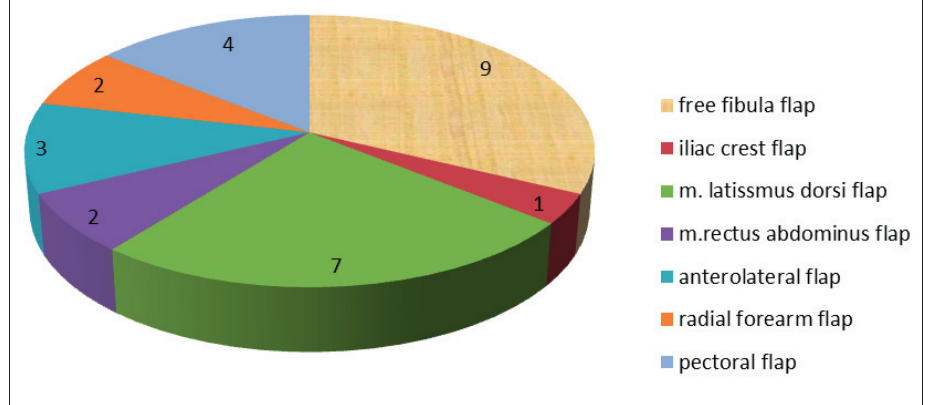
Fig. 1. Distribution of flaps used for reconstruction.